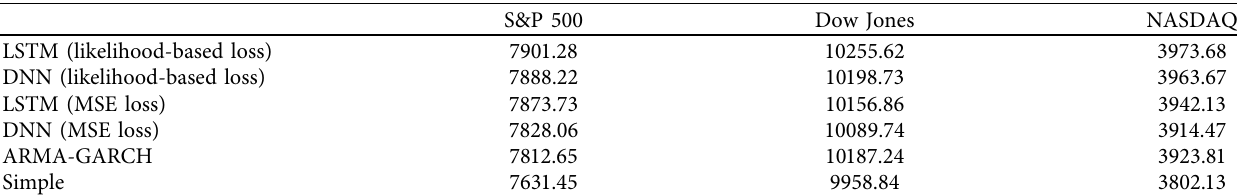
Table 9: Log likelihoods of the test sample when the test set is